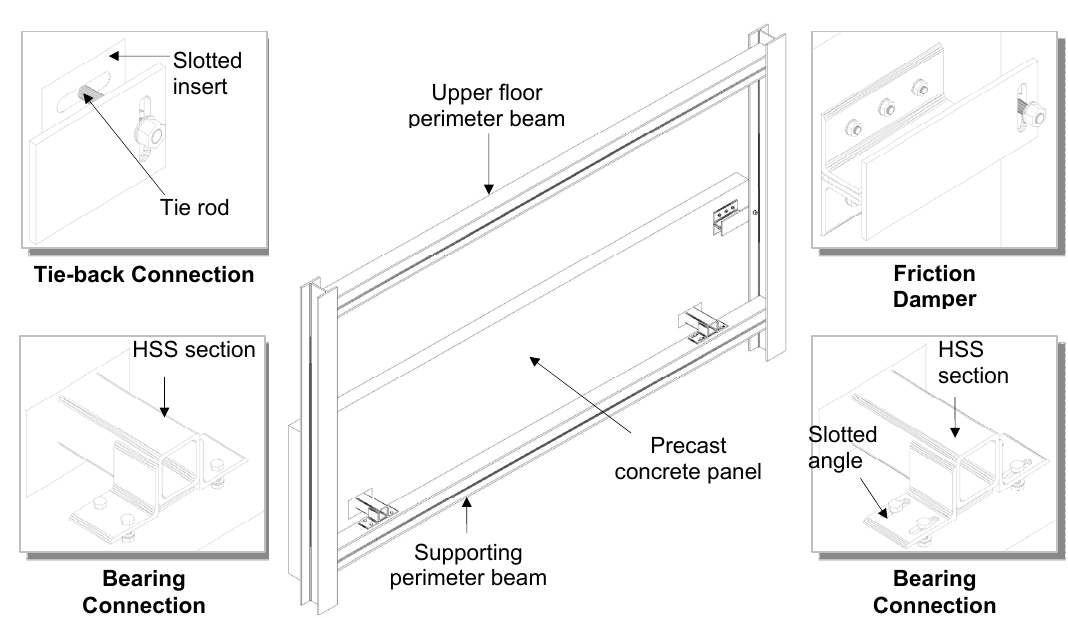
Figure 2. Components of